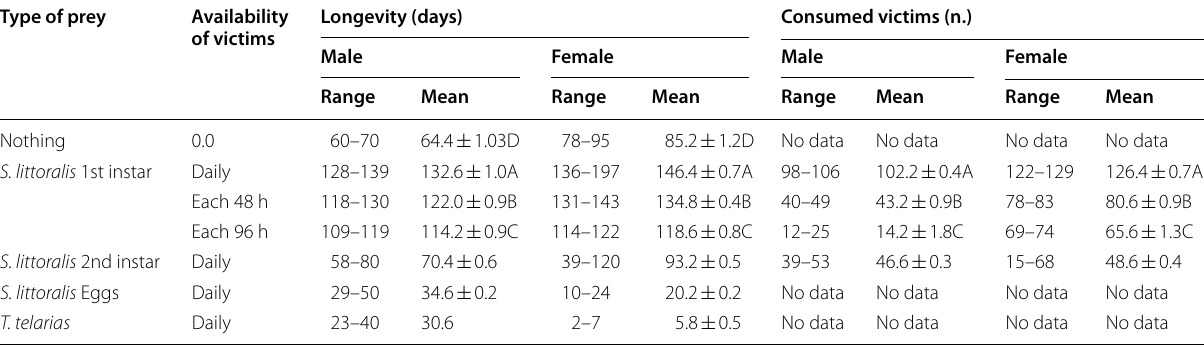
Table 4 Effect of prey type and its availability on the longevity of newly formed adults and the amount of predated victims by